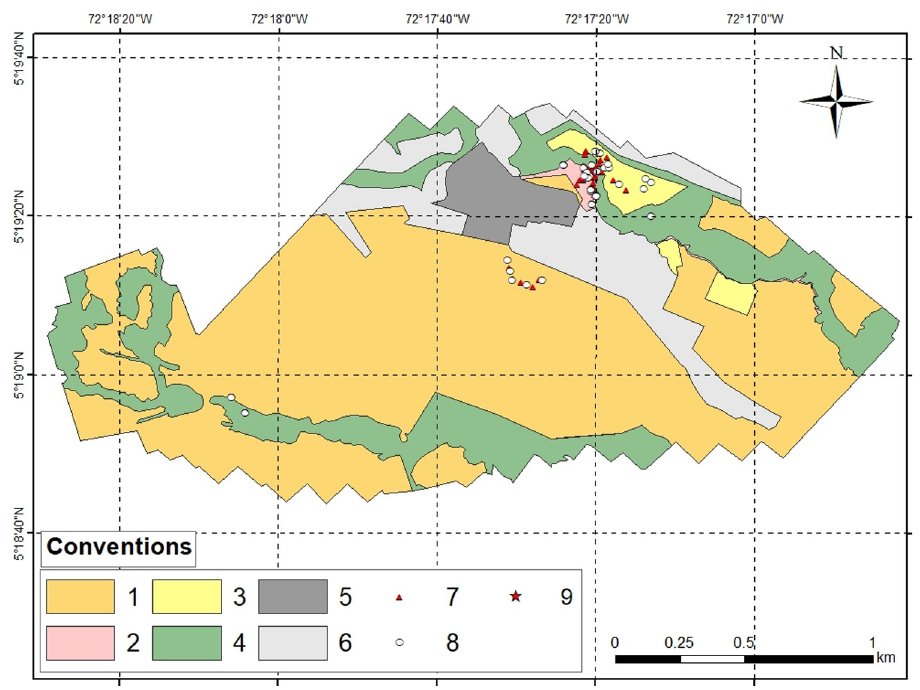
Fig 2. Derived map of the Matepantano farm study area and the four selected habitats. The study area is about 3.2 km 2 representing a 6% of the total area of Matepantano estate. Conventions: 1- Star Grass paddocks (1’955,090 m 2 ); 2- King Grass crop (22,416 m 2 ); 3- Cocoa crop (81,341 m 2 ); 4- Riparian Forest (646,099 m 2 ); 5- Main buildings area (112,833 m 2 ); 6- Other area (386,007 m 2 ); 7- CO 2 traps; 8- Dragging by cloth transects; 9- Regional localization of the Matepantano farm. Note: All CO 2 traps and dragging by cloths transects with GPS data for both the dry and wet seasons are represented.